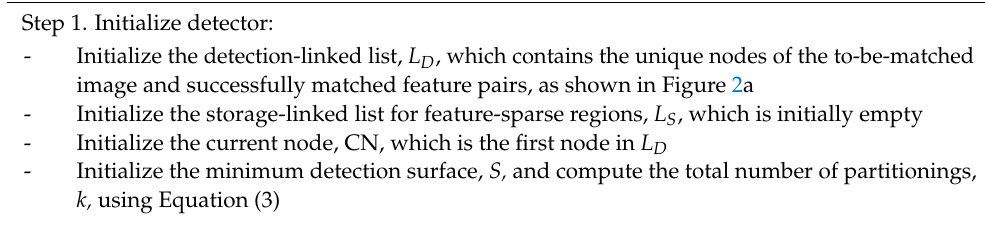
Algorithm 1. Feature-Sparse Region